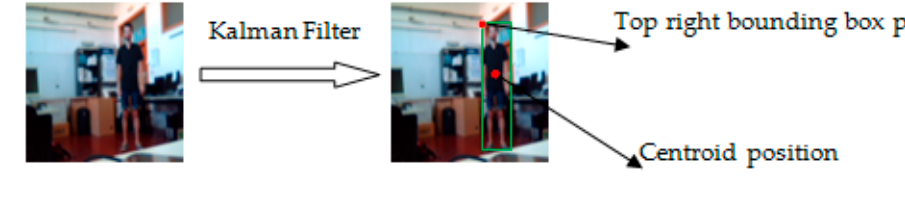
Figure 5. Human tracking using the Kalman filter.